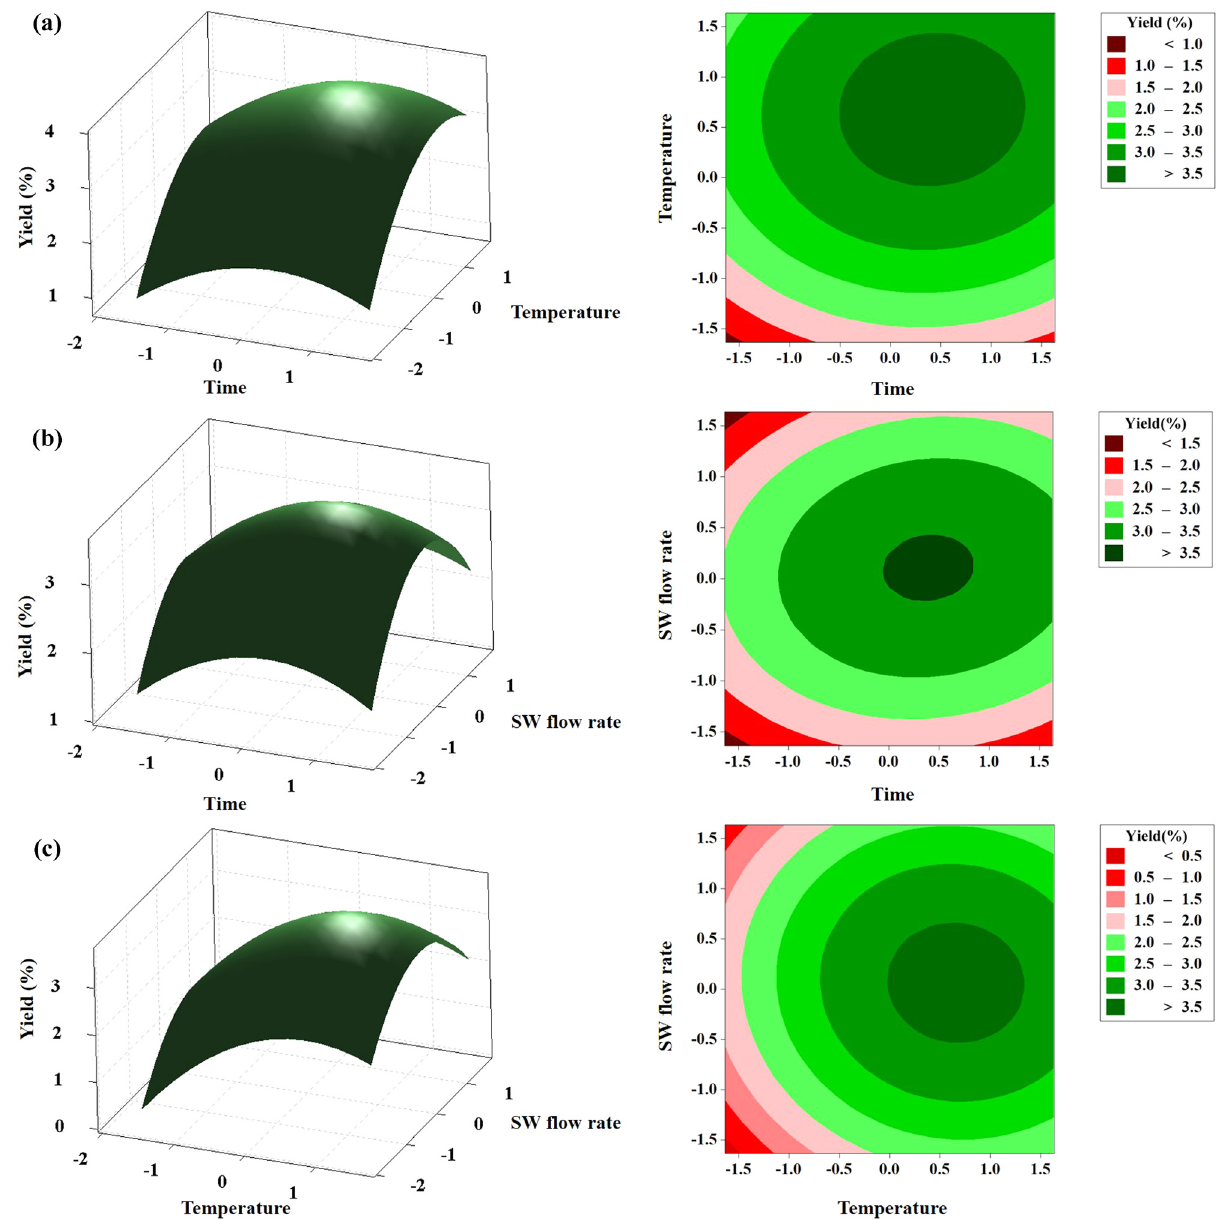
Figure 2: Response surface and contour plots of the yield of the total anthraquinones a ff ected by extraction time, extraction temperature, and SW fl ow rate. ( a ) The interactive e ff ect of extraction temperature and time on the yield of the total anthraquinones; ( b ) the interactive e ff ect of the SW fl ow rate and extraction time on the yield of the total anthraquinones; ( c ) the interactive e ff ect of the SW fl ow rate and extraction temperature on the yield of the total